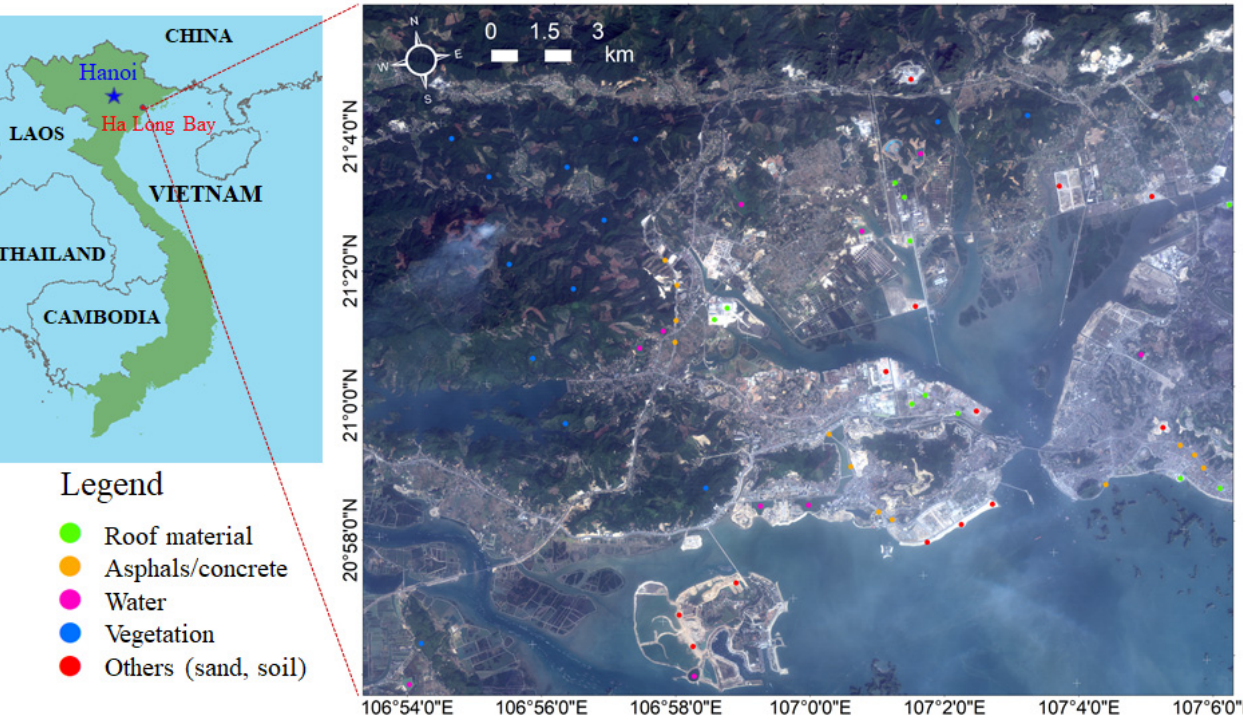
Figure 1. The study area located in Ha Long Bay and the locations of different ground targets are shown. The RGB image derived from FS5 with 4 m resolution captured on 11 November 2019.